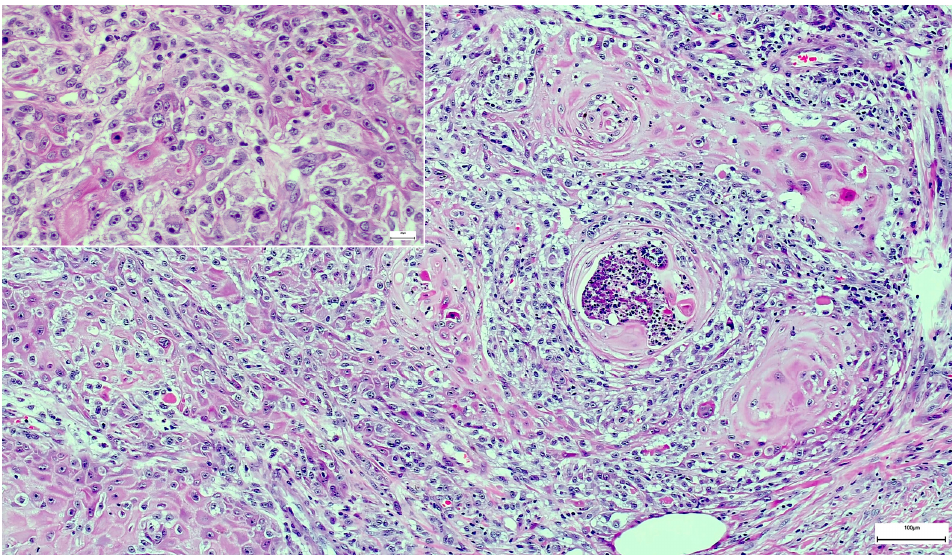
Figure 3. Detail of the invasion front: Large pale keratinocytes and epithelial nests with micro abscesses in a background of spindle-shaped melanoma cells (H&E stain).